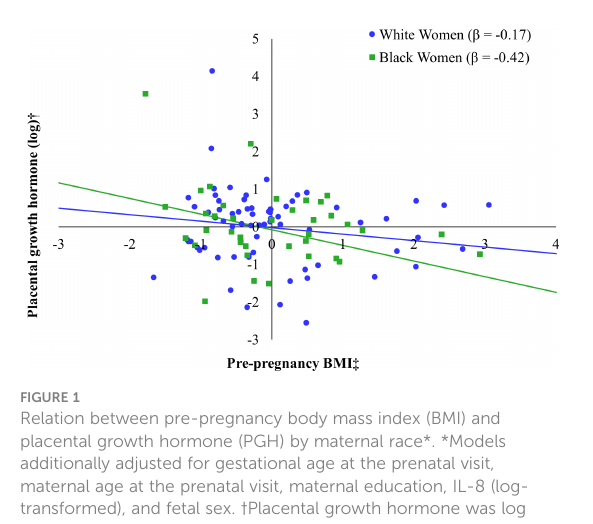
FIGURE 1 Relation between pre-pregnancy body mass index (BMI) and placental growth hormone (PGH) by maternal race*. *Models additionally adjusted for gestational age at the prenatal visit, maternal age at the prenatal visit, maternal education, IL-8 (log- transformed), and fetal sex. † Placental growth hormone was log transformed. ‡ Pre-pregnancy BMI was captured by self-report at the prenatal visit.